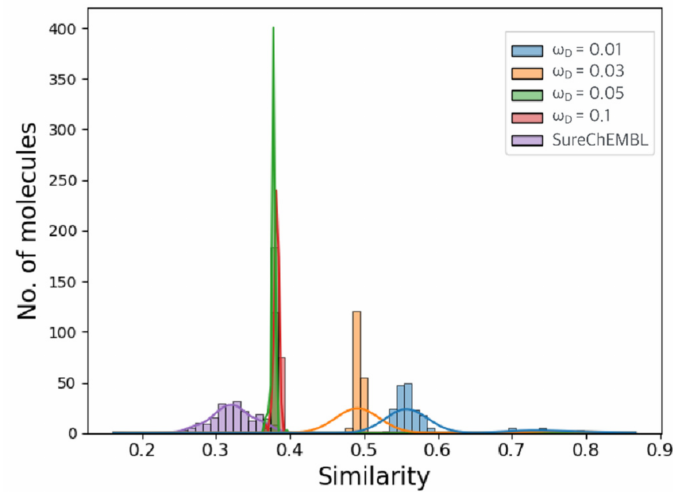
Figure 3. Distributions of the docking score ( top ), QED ( middle ), and a similarity to the reference ( bottom ) of the generated molecules with the known molecules in SureChEMBL while varying the weight coefficient of the docking score term. The distribution of the ( top ) docking energy, ( middle ) QED, and ( bottom ) similarity according to the weight change are plotted. Purple indicates the distribution of the SureChEMBL dataset (the 500 molecules with the lowest docking energy), and blue indicates results when an ω D value of 0.01 is used. Orange is the property distribution of molecules generated using a ω D value of 0.03, green indicates the results using a ω D value of 0.05, and red indicates the results using a ω D value of 0.1. We can see that the docking energy of the SureChEMBL dataset using the lowest value of ω D (0.01) is lower than that of the SureChEMBL dataset. Still, QED and similarity show the highest distribution. When using an ω D value of 0.03, we found that the docking energy of the generated molecule was lower than that of the SureChEMBL dataset value, and the QED generated had higher values than that of the dataset. With ω D values of 0.1 and 0.05, the molecules with the lowest docking energy were generated using high weights. The QED and the similarity were found to be lower than the values generated using an ω D value of